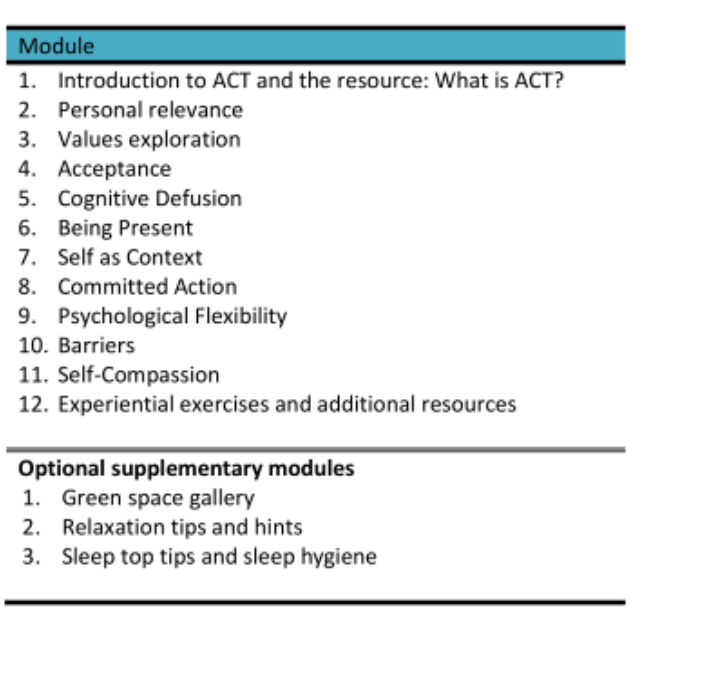
Figure 4. Intervention